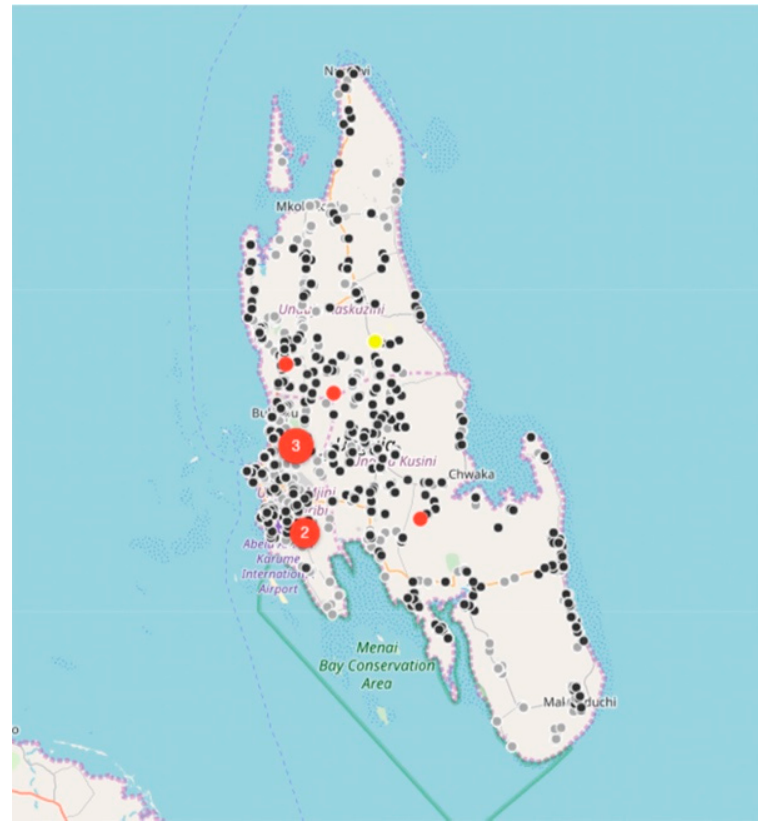
Figure 4. Maps of Unguja island showing the location of laboratory-confirmed animal rabies cases (red dots), clinically confirmed human rabies cases (yellow dots), locations of vaccinated animals in 2017 (grey dots) and locations of vaccinated animals in 2018 (black dots). The number of rabies cases per location is displayed in terms of the size and the number within each red dot. Only the location of the vaccinated animals is displayed on the map (grey and black dots) for ease of interpretation. On this specific map, the total number of grey and black dots represent the 6631 animals vaccinated between August 2017 and December 2018.